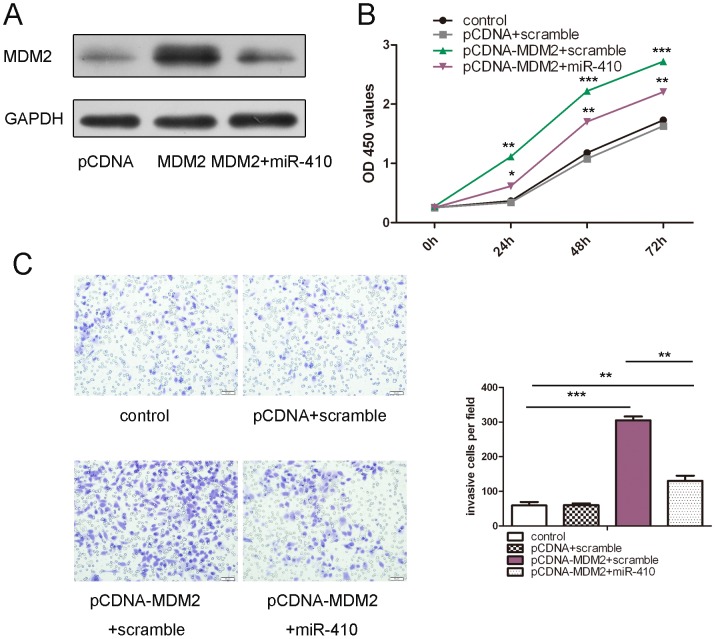
Overexpression of MDM2 impaired miR-410-induced inhibition of proliferation and invasion in GC cells (A) Western blot analysis of MDM2 in HGC-27 cells co-transfected with either miR-410 mimic or scramble and 2.0 µg pCDNA-MDM2 or pCDNA empty vector.(B) Cell growth curves in HGC-27 cells transfected with different combinations. (D) Transwell analysis of HGC-27 cells treated with different combinations. The relative ratio of invasive cells per field is shown right. *p<0.05, ** p<0.01, ***p<0.001.